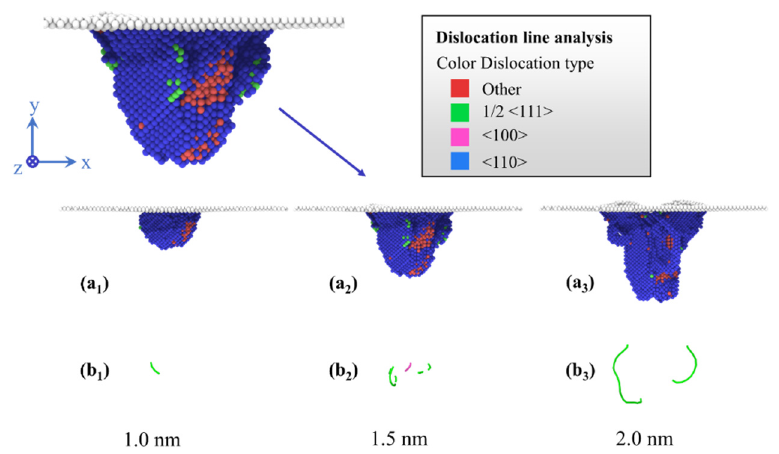
Figure 4. Instantaneous ( a1 – a3 ) atomic configurations, combined with ( b1 – b3 ) dislocation line evolutions during the indentation at 1 wt.% versus indentation penetration depth: ( a1 , b1 ) 1.0 nm; ( a2 , b2 ) 1.5 nm; ( a3 , b3 ) 2.0 nm. ( a1 – a3 ) Except for boundary atoms shown in white, atoms inside the substrate are colored according to CNA, as HCP atoms (green), BCC atoms (yellow) and the other atoms (blue). ( b1 – b3 ) The DXA is used to assign dislocation, as 1/2<111> (green), <100> (purple) and <110>dislocation (blue).